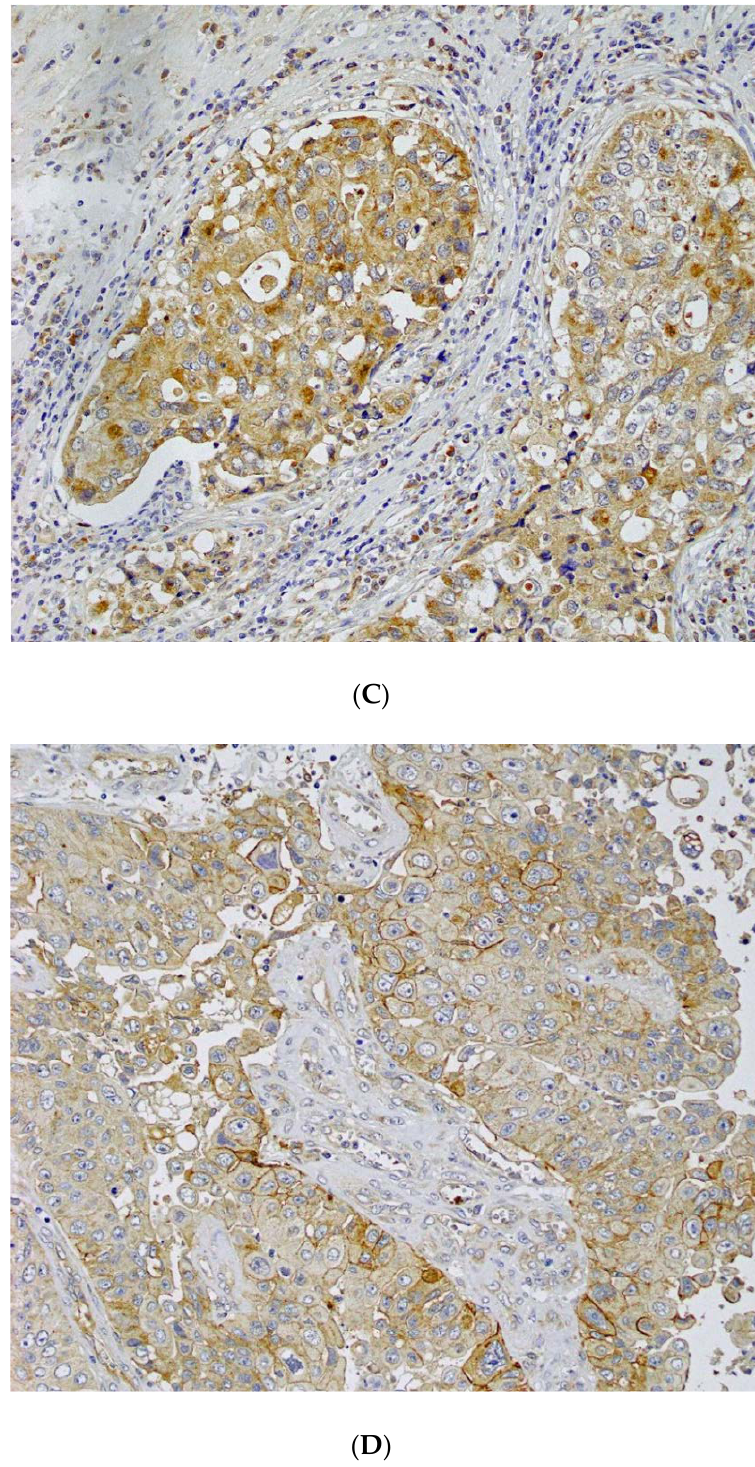
Figure 1. CD155 expression in non-neoplastic urothelial cells and urothelial carcinoma. ( A ) No or weak staining was observed in the non-neoplastic urothelial cell; ( B ) negative staining; ( C ) cytoplasmic staining; ( D ) membranous staining in urothelial carcinoma cells (original magnification, 400 ×).